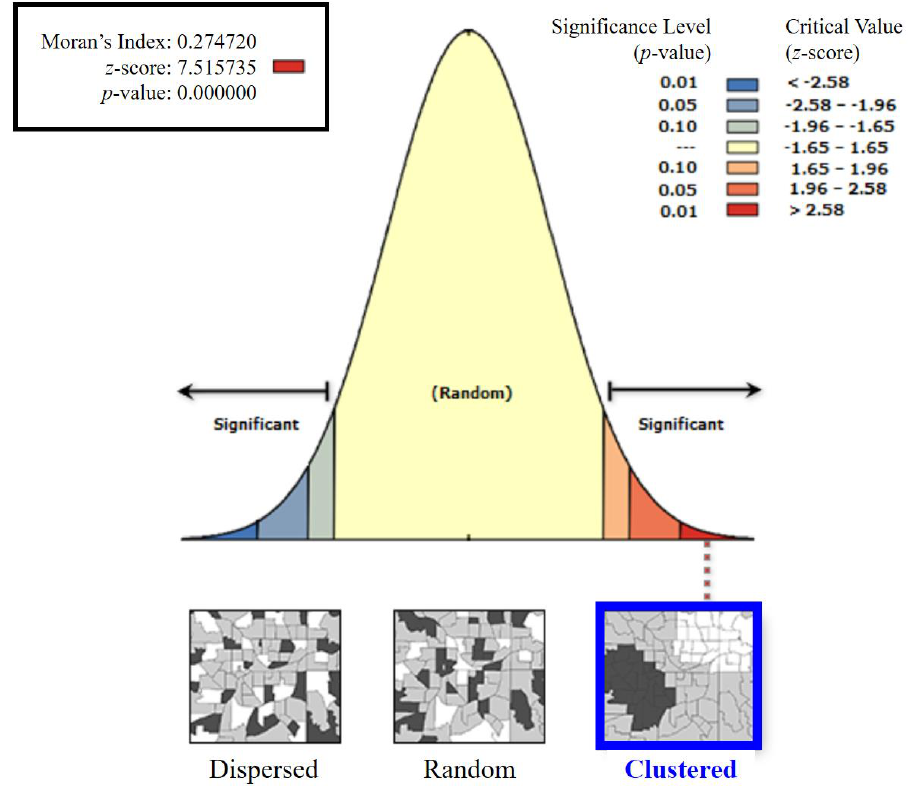
Figure 3. Global Moran’s I statistic results yielded by the Spatial Autocorrelation tool in ArcMap 10.1. The tendency of the feature pattern obtained in the study area toward clustering is apparent. Int. J. Environ. Res. Public Health 2017 , 14 , 654